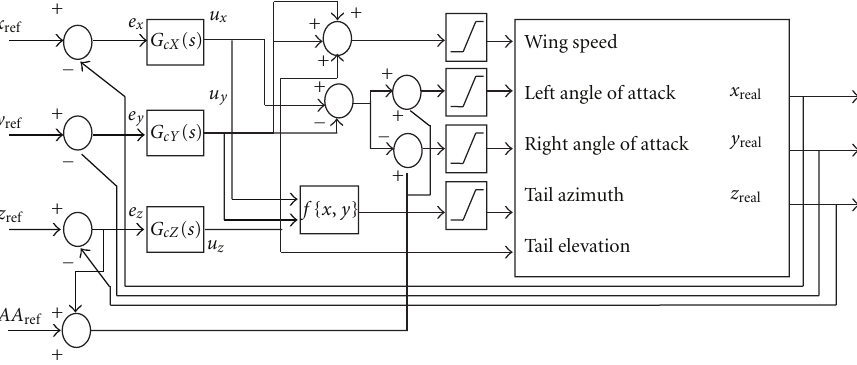
Figure 16: Control diagram of the dragonfly